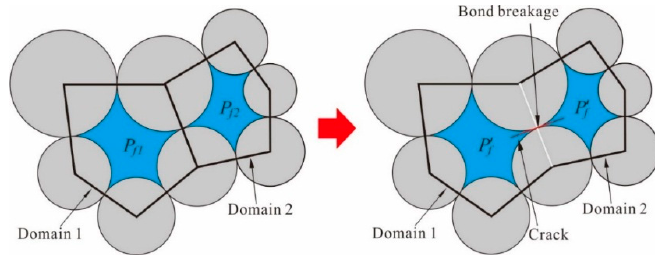
Figure 4. Bond breakage and fluid pressure balancing according to Equation (15) in two related domains.